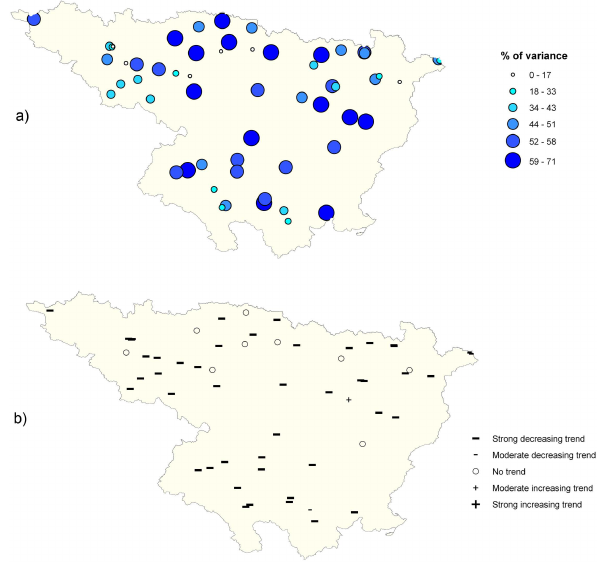
Fig. 5. Results of the application of a stepwise linear regression for predicting annual runoff from annual temperature and precipitation over the 88 sub-basins analyzed in the Ebro basin. 5a: the coeffi- cient of determination for each sub-basin. (b) trends in the evolution shown by residuals in each